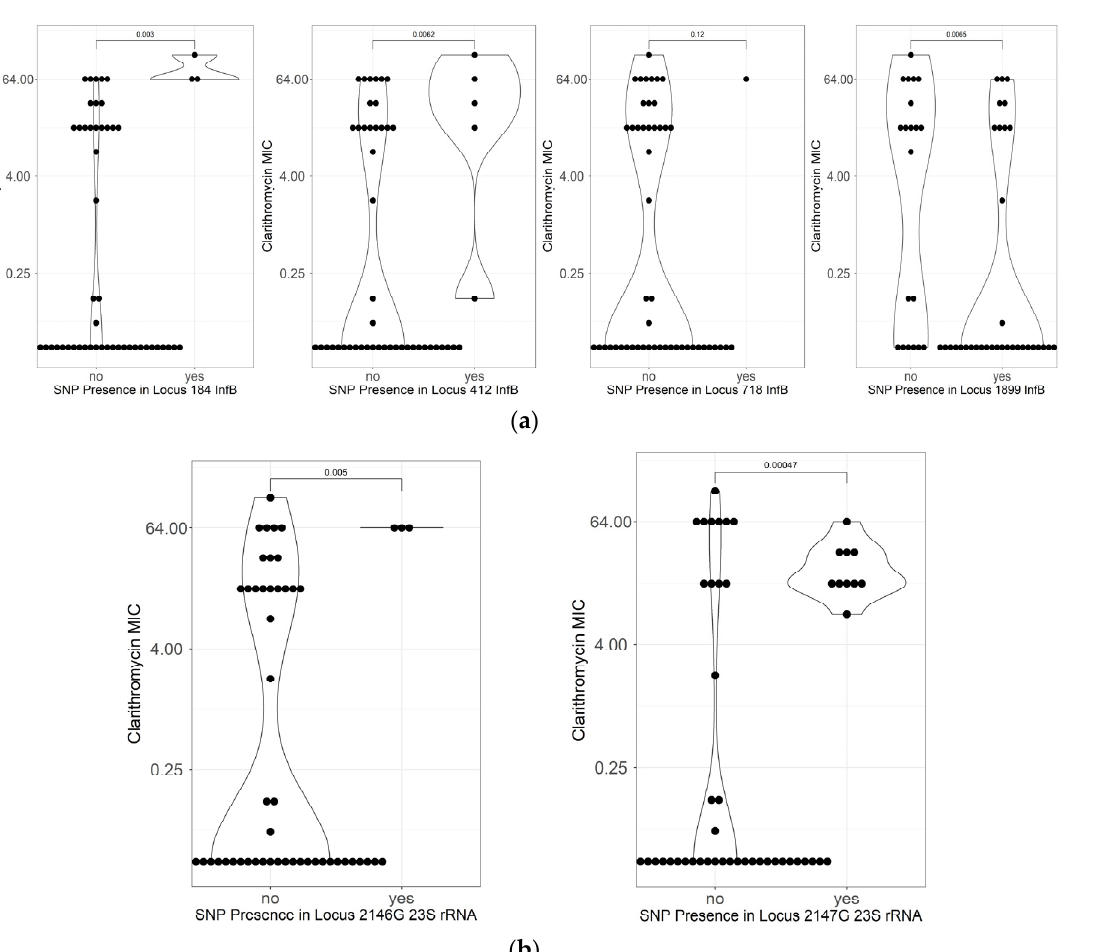
Figure 4. Distributions of MIC in the presence and absence of mutations. The MIC is plotted as y - axis and mutation were represented by dots. Mutations in infB and 23S rRNA genes associated with higher clarithromycin MIC. ( a ) MIC comparisons mutations in the infB genes . ( b ) MIC comparisons mutations in the 23S rRNA genes .